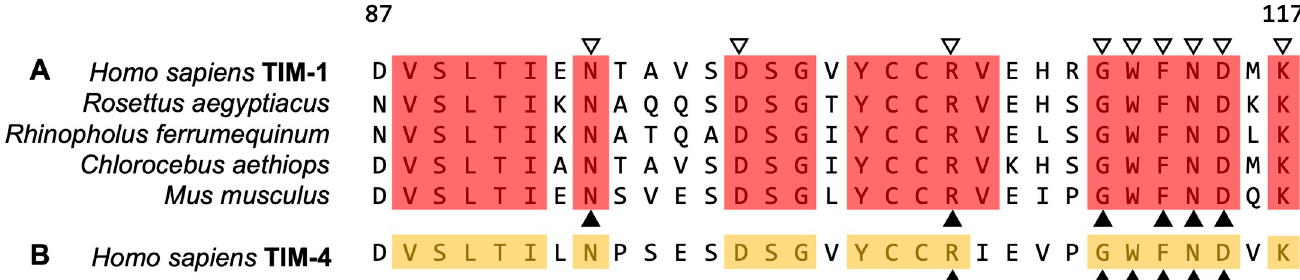
Fig 1. The TIM-1 PS binding pocket is highly conserved across a wide range of mammalian genomes. (A) TIM-1 amino acid sequences from NCBI were accessed for human, Egyptian fruit bat, greater horseshoe bat, African green monkey, and house mouse and aligned using CLUSTAL O . A region of 30 residues is shown here, encompassing the IgV binding pocket. Highlighted residues have complete identity across all species examined, 5 depict residues that, if mutated (to alanine), decrease EBOV pseudovirion transduction > 20%, and ▲ indicates residues that, if mutated, decrease EBOV GP-rVSV infection > 20% according to Moller-Tank and colleagues [45]. (B) Alignment of TIM-4 amino acid sequence to TIM-1 as above. Highlighted residues have identity to all TIM-1 sequences shown, and ▲ indicates residues that, if mutated, significantly reduce transduction and AU : PleasenotethatasperPLOSstyle ; italicsshouldnotbeusedforemphasis : Hence ; pleaseadviseifandinthesentence ::: significantlyreducetransductionandinfectionaccordingtoRhein ::: shouldbechangedtoRomanstyleorbeenclosedinquotationmarks : infection according to Rhein and colleagues [30]. EBOV GP-rVSV, Ebola virus glycoprotein-recombinant vesicular stomatitis virus; IgV, immunoglobulin V; PS, phosphatidylserine.